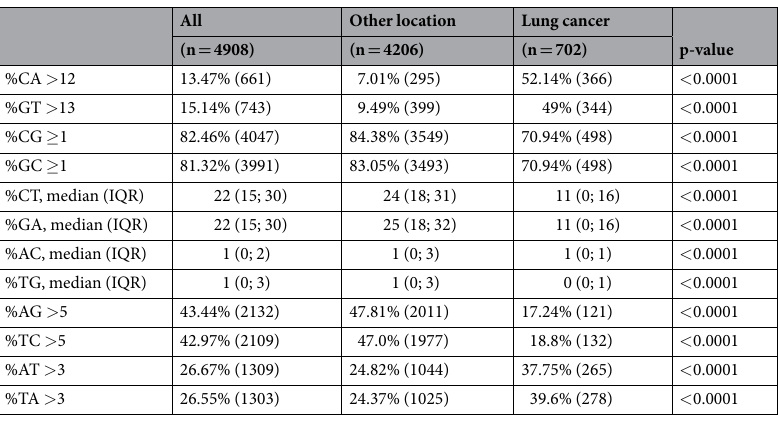
Table 1. Distribution of the relative frequencies of the 12 substitution classes in the development dataset for the 4,908 tumors with a somatic substitution prevalence of ≥ 1 sub/Mb. Results presented as percentage and frequency %(n) unless otherwise indicated. IQR: interquartile range; %CA = relative frequency of C > A substitutions (%); %GT = relative frequency of G > T substitutions (%); %CG = relative frequency of C > G substitutions (%); %GC = relative frequency of G > C substitutions (%); %CT = relative frequency of C > T substitutions (%); %GA = relative frequency of G > A substitutions (%); %AC = relative frequency